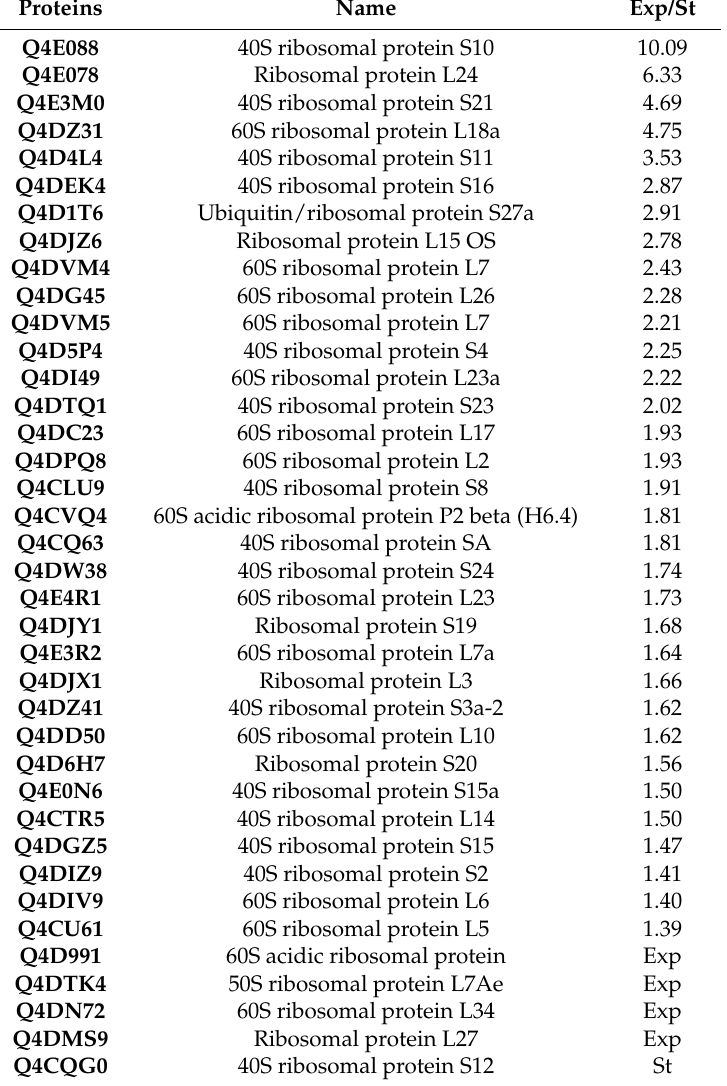
Table 1. Ribosomal proteins regulated during transitioning from the exponential to the stationary growth phase. The exponential to stationary phase ratio is reported. Exp and St indicate proteins that were uniquely identified in the exponential and stationary phase,